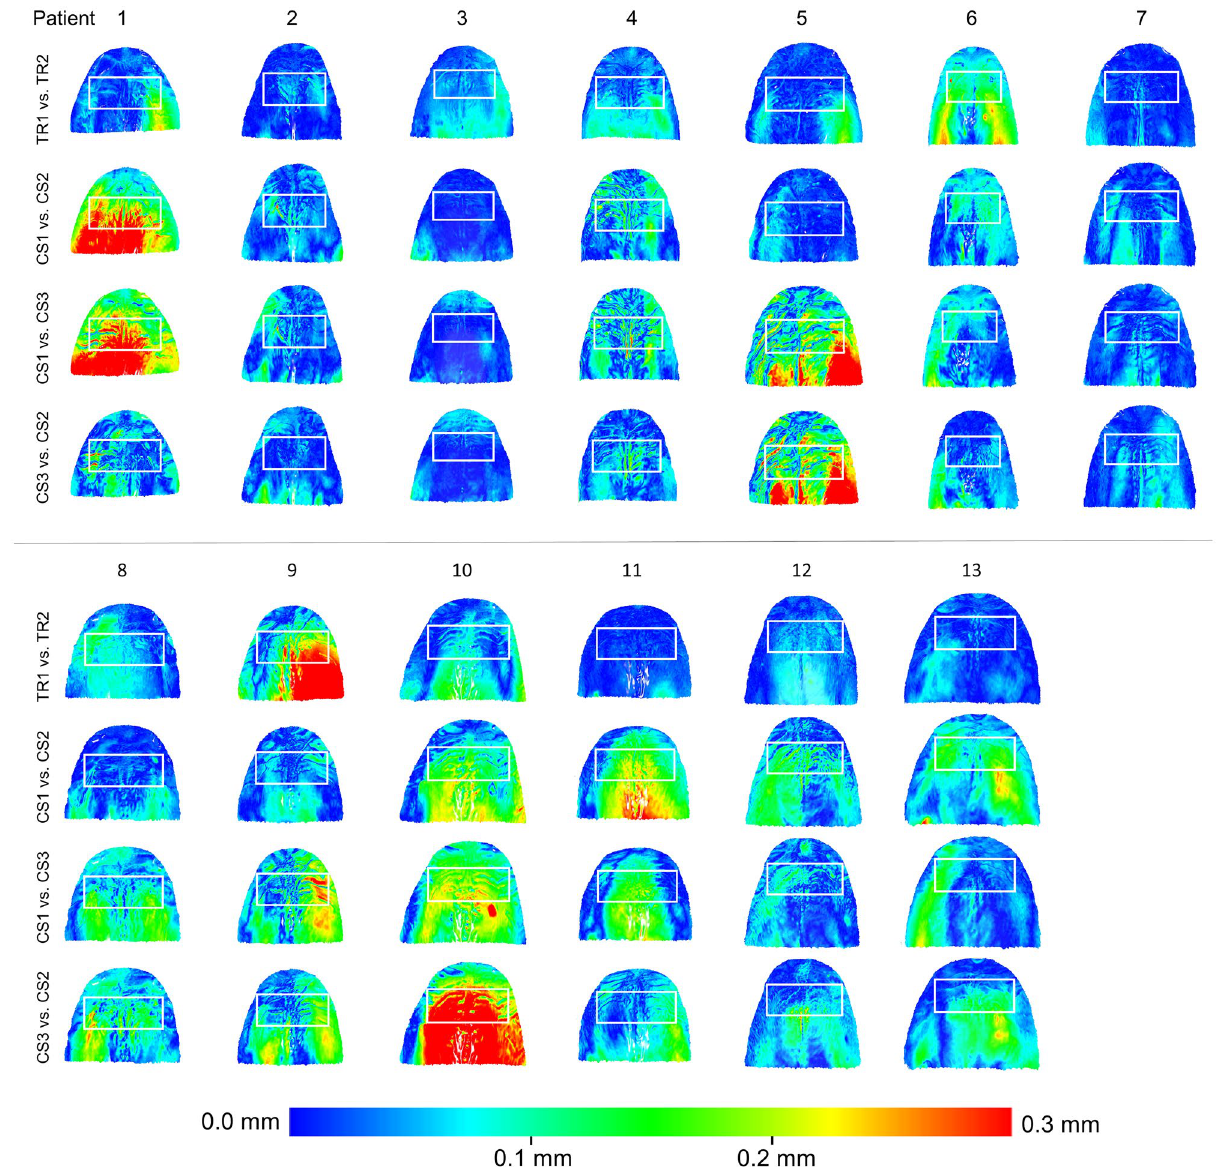
Figure 4. Colour coded distance maps showing the precision of the intraoral scanners in area B, when repeated models were superimposed on the dental arch. Three scans from CS 3600 (CS1, CS2, CS3) and two scans from TRIOS3 (TR1, TR2) were assessed. The white box indicates area A. All images were generated using Viewbox 4 software (version 4.1.0.1 BETA, http:// www. dhal. com/ viewb oxind ex.